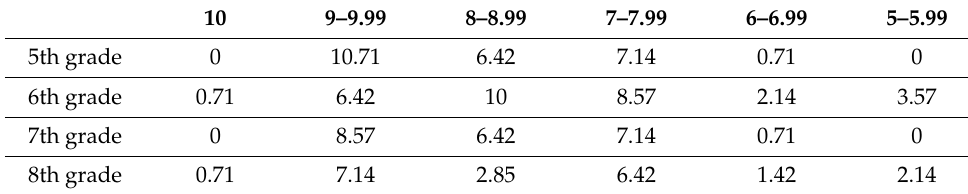
Table 4. Averages in second semester during COVID pandemic with online courses (%).